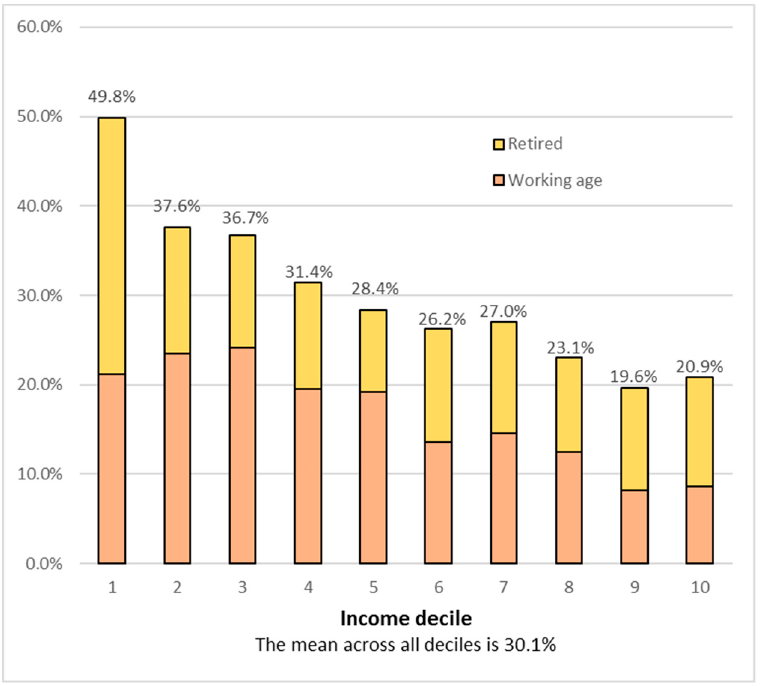
Figure 5. Percentage of single person households by income decile. Using household equivalent net